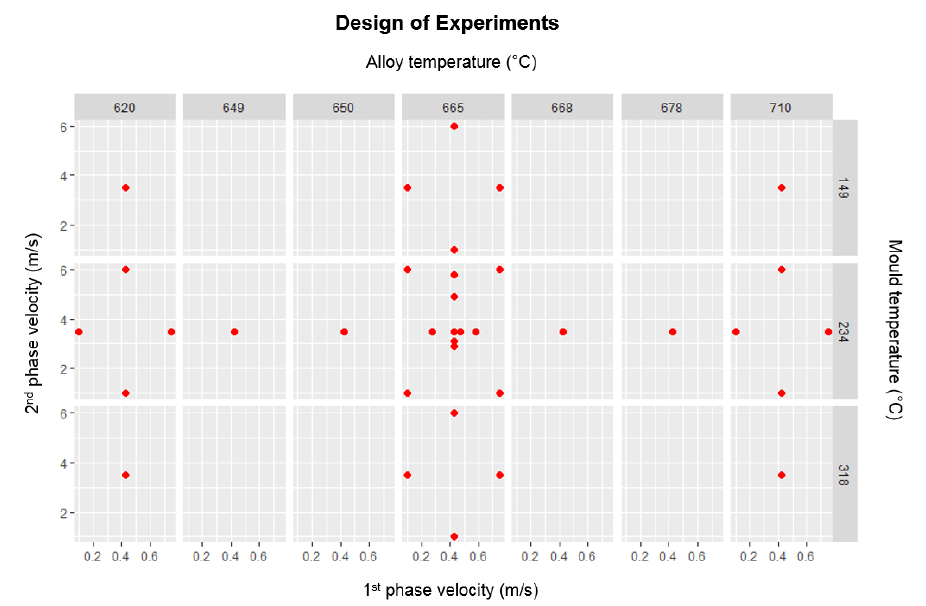
Figure 8. Instances obtained from the